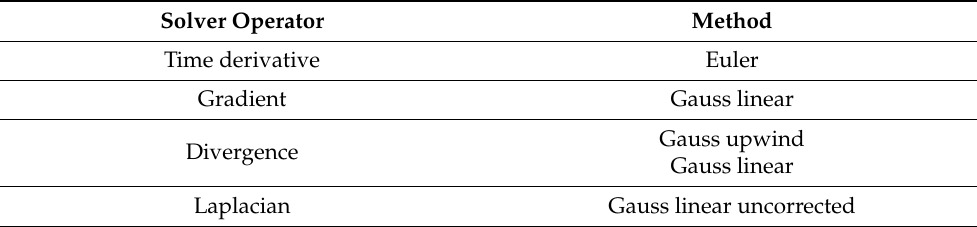
Table 3. Numerical solvers applied in BoussinesqRTDFoam solver.